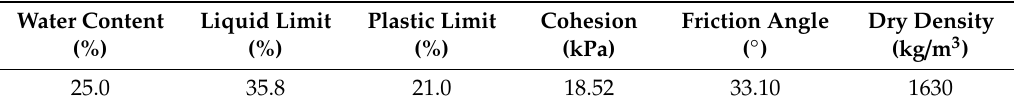
Table 2. Soil sample parameters